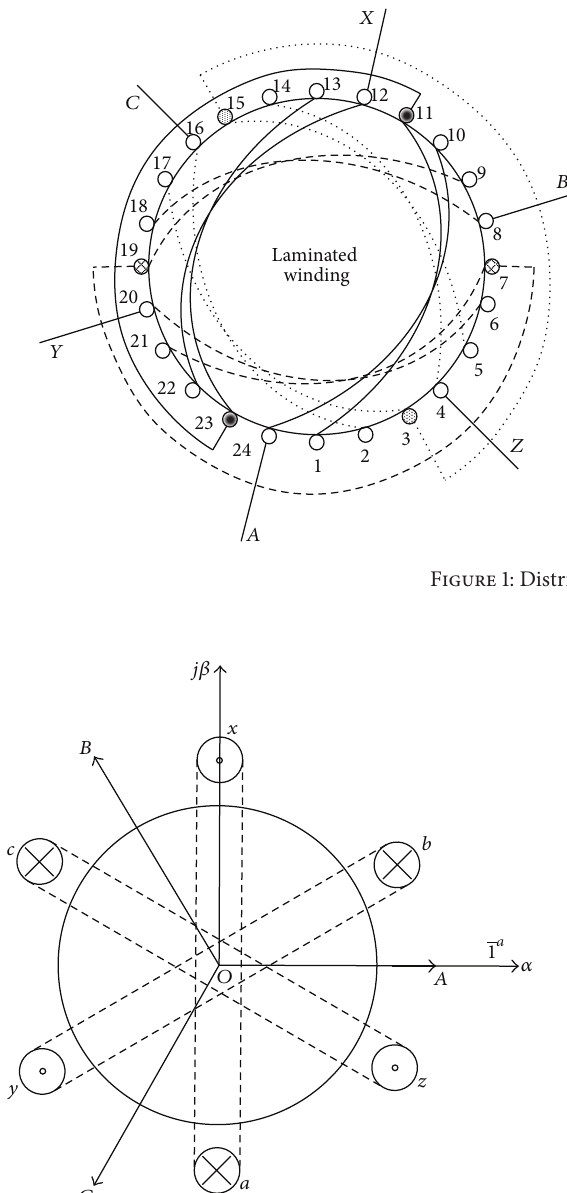
Figure 2: Simplified stator model of synchronic